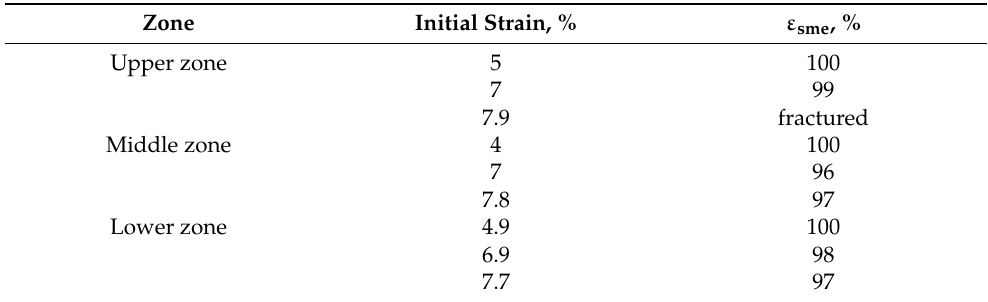
Table 3. The results of the bending tests during the investigation of the shape-memory effect for each zone of the as-deposited specimen.